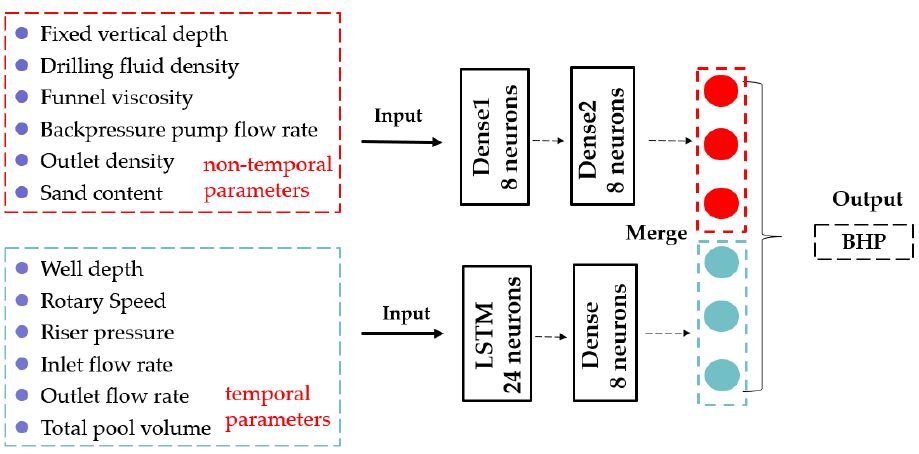
Figure 7. BP-LSTM parallel network internal detailed structure.